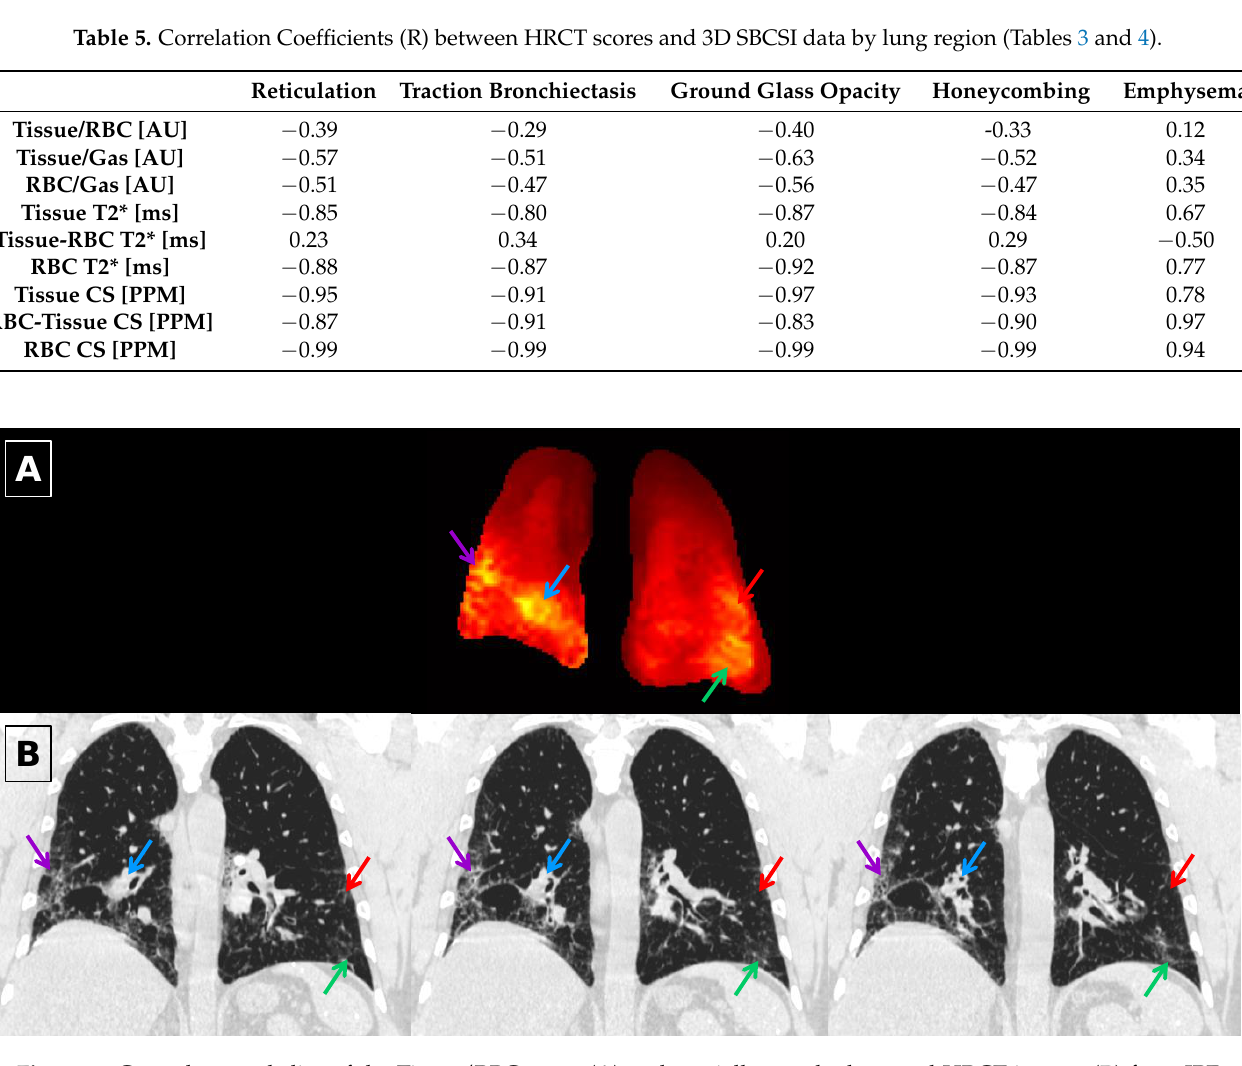
Figure 8. Central coronal slice of the Tissue/RBC maps ( A ) and spatially matched coronal HRCT images ( B ) from IPF subject I6. Due to the difference in the slice thickness between the Tissue/RBC maps (15 mm) and HRCT images (0.7 mm), information from multiple nearby HRCT images could appear in a single slice of the Tissue/RBC maps. Each arrow points to a region of high Tissue/RBC, and the same color arrow points to the corresponding region of fibrosis in the HRCT images.